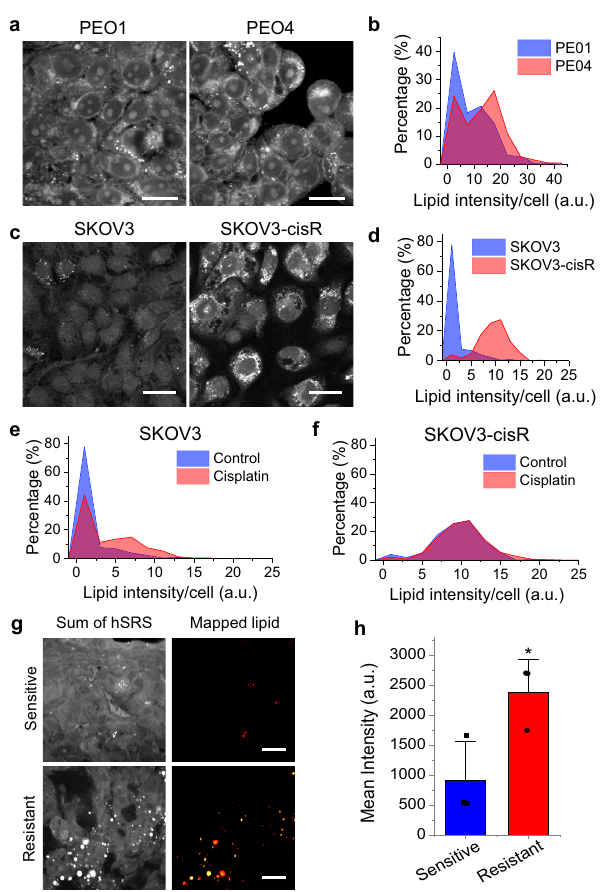
Fig. 1 | High-throughput imaging of lipid metabolism in isogenic pairs of cisplatin-sensitiveand-resistantOCcells.a Representativelarge-areaSRSimages of parental PEO1 and cisplatin-resistant PEO4 cells. b Histograms of integrated cellular lipid intensity in PEO1 and PEO4 cells generated through high-throughput single-cell analysis. c Representative large-area SRS images of parental SKOV3 and cisplatin-resistant SKOV3-cisR cells. d Histograms of integrated cellular lipid intensity in SKOV3 and SKOV3-cisR cells. e Histograms of integrated cellular lipid intensityinSKOV3cellstreatedwithorwithoutcisplatin. f Histogramsofintegrated cellular lipid intensity in SKOV3-cisR cells treated with or without cisplatin. g Representative hyperspectral SRS image (sum of all channels) and Phasor map- ped lipid image ofsliced OVCAR5xenograft tumor tissue from mouse treated with vehicle (sensitive) or carboplatin (resistant). h Quantitative analysis of SRS signal from lipid in carboplatin sensitive and resistant ovarian tumor tissue by mean intensity. Data are presented as means + SD; n =3 animals; two-sided Student ’ s t test; P =0.043;* P <0.05.Scalebar:20 µ m.SourcedataareprovidedintheSource Data fi